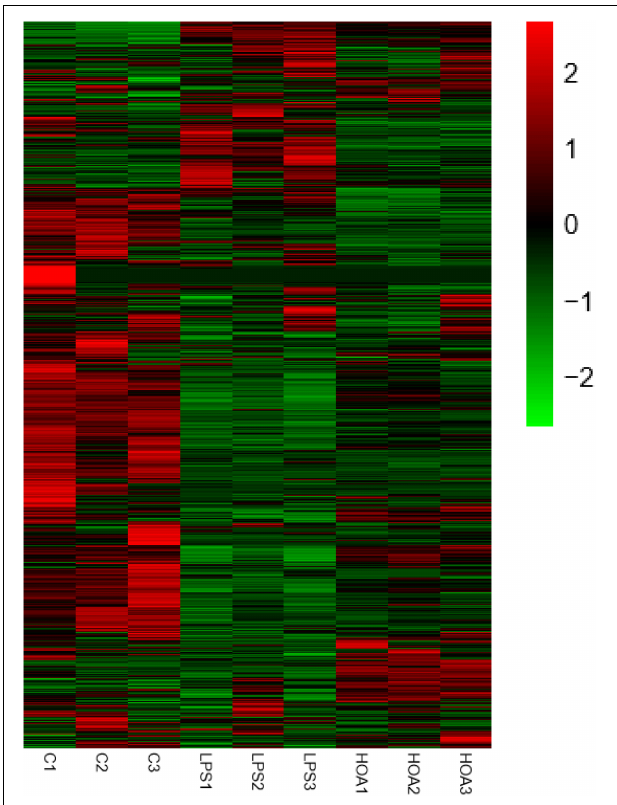
FIGURE 3 | Differential gene expression change heat map. Red represents the upregulated genes, green represents the downregulated genes, and black represents no significant difference in genes